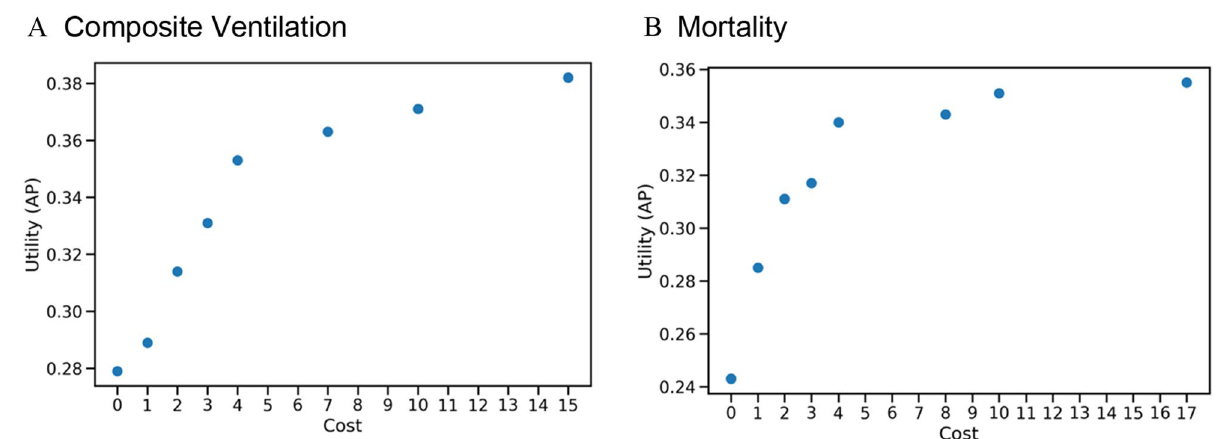
Figure 7. Visualization of Total cost versus Utility. Although an increase in budget allows more clinical feature groups in our selection, this does not guarantee an increase in performance. The performance maximizes